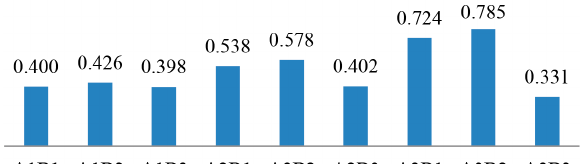
Figure 7 Alternative ranking of Cucumis melo product acceptance CONFLICT OF INTEREST The authors declare no conflict of